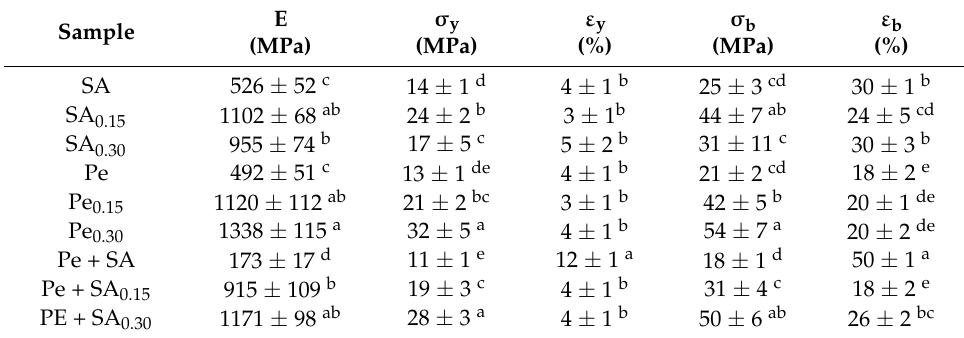
Table 3. Mechanical data of SA, Pe and SA + Pe films.